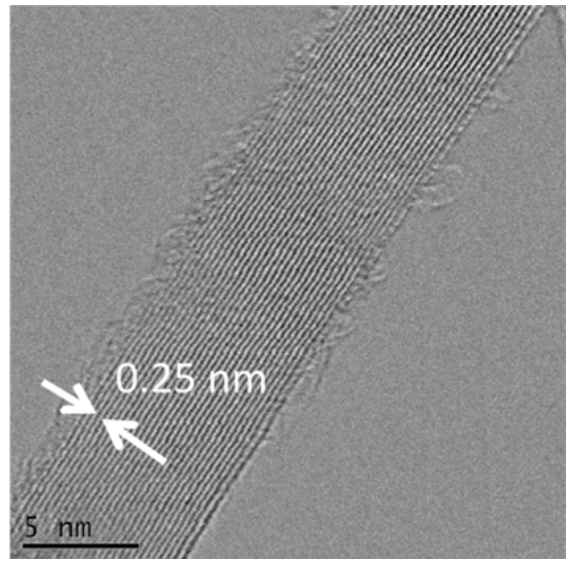
Figure 7. High Resolution STEM image of the whisker stem.